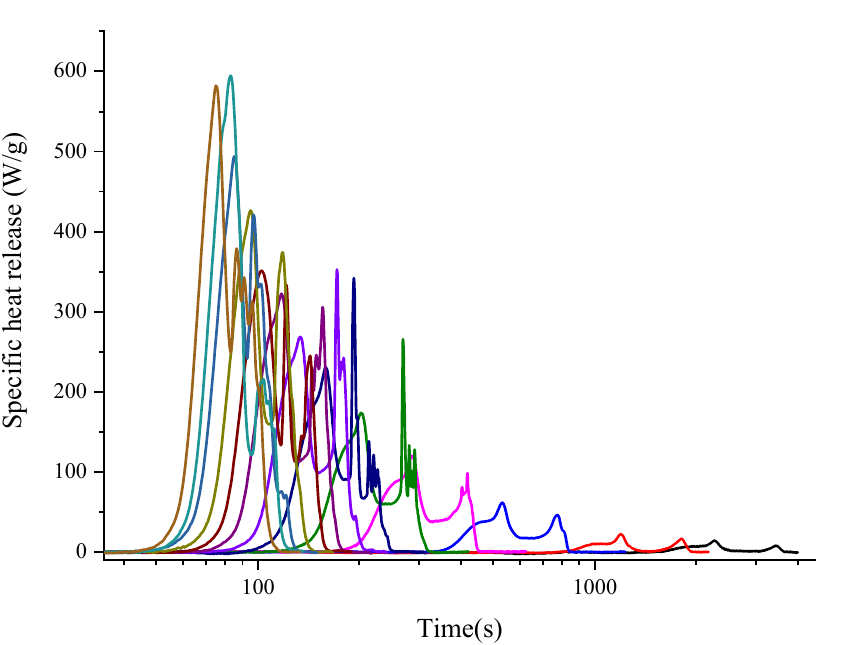
Figure 3. Specific heat release rate curve of BB sample with 13 heating rates ranging from 0.1 to 5.5 K s − 1 by MCC Method B. (Different color means different heating rates. From right to left is 0.1, 0.2, 0.5, 1.0, 1.5, 2.0, 2.5, 3.0, 3.5, 4.0, 4.5, 5.0, and 5.5 K s − 1 .).